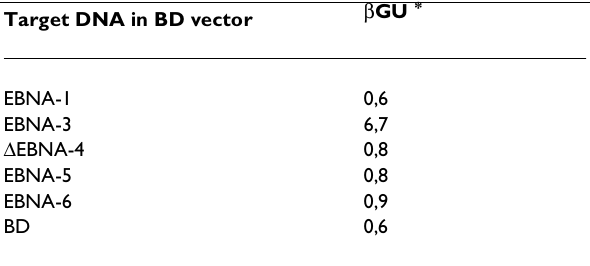
Table 1: Specific activity in β -galactosidase units of 538 co-trans- formants in yeast strain SFY526 Target DNA in BD